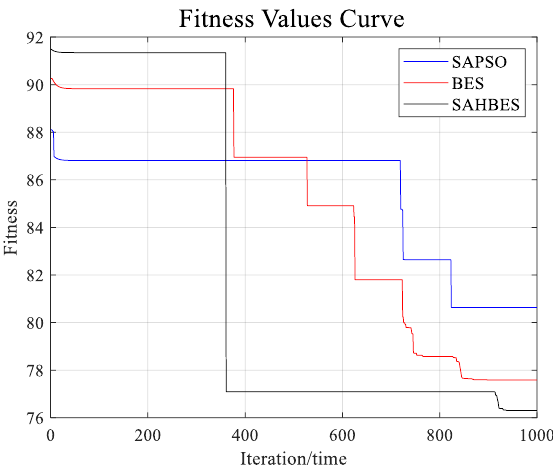
Figure 14. Comparison of the three algorithms’ fitness values of simulation III.